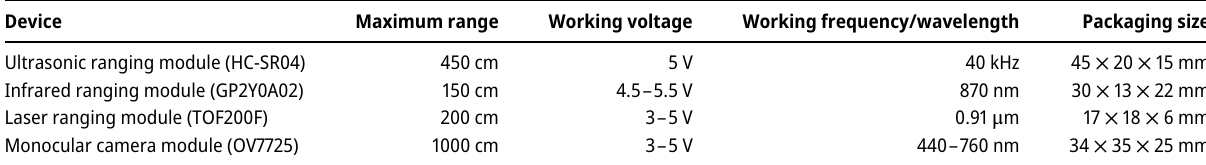
Figure 4: Beam modulation of the metasurface: (a) the four different spectrum detectors that ultrasonic ranging module, infrared ranging module, laser ranging module, and monocular camera module (b) phase profile with 180 ◦ phase difference; (c) theoretically calculated far-field beam mode in phase profile at (b); (d) simulated far-field mode in phase profile at (b); (e) phase profile with 120 ◦ phase difference; (f) theoretically calculated far-field beam mode in phase profile at (e); (g) simulated far-field mode in phase profile at (e). Table 1: The technical parameters of spectrum detectors. Device Maximum